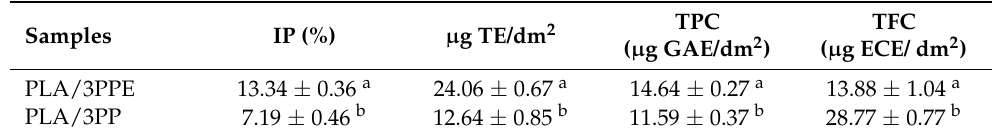
Table 3. Antioxidant capacity and total content of phenolic compounds and flavonoids of the active PLA films.